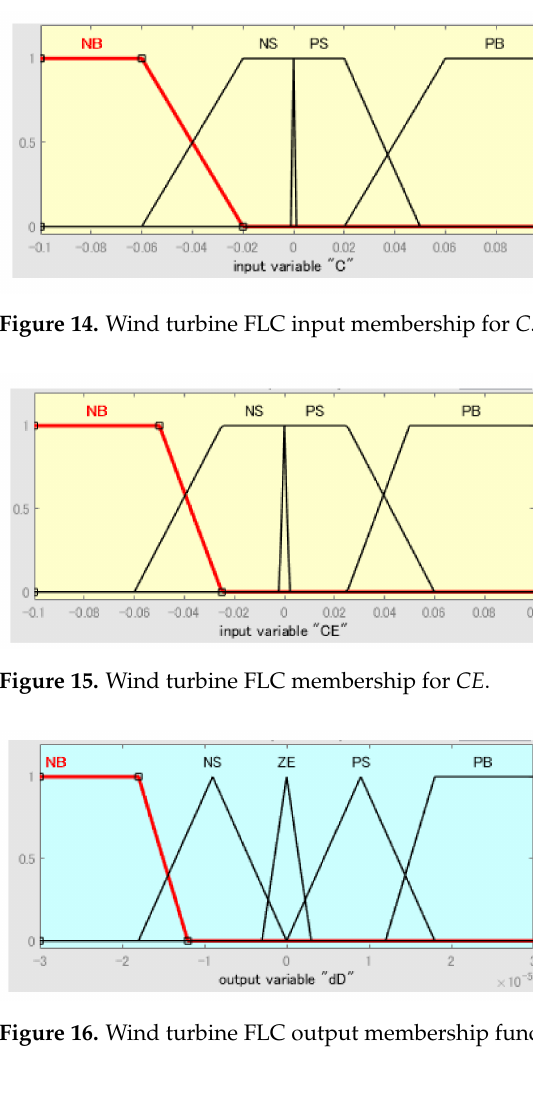
Figure 13. Simulink model of the fuzzy controller for the wind generator. Table 5 represents the fuzzy rules that are used in the wind turbine MPPT system. Figures 14–16 show membership functions for E ( k ) , CE ( k ) and ∆ D , respectively. Table 6 represents the fuzzy rules.